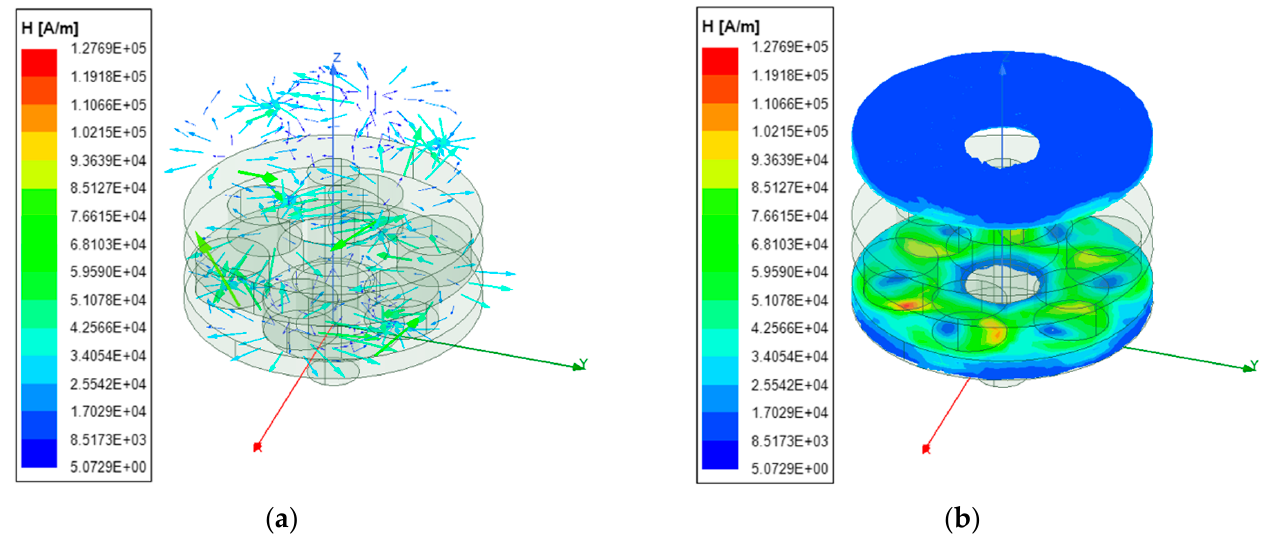
Figure 13. Transient magnetic field strength distribution of the rotor disks: ( a ) Vector distribution; ( b ) Field distribution.